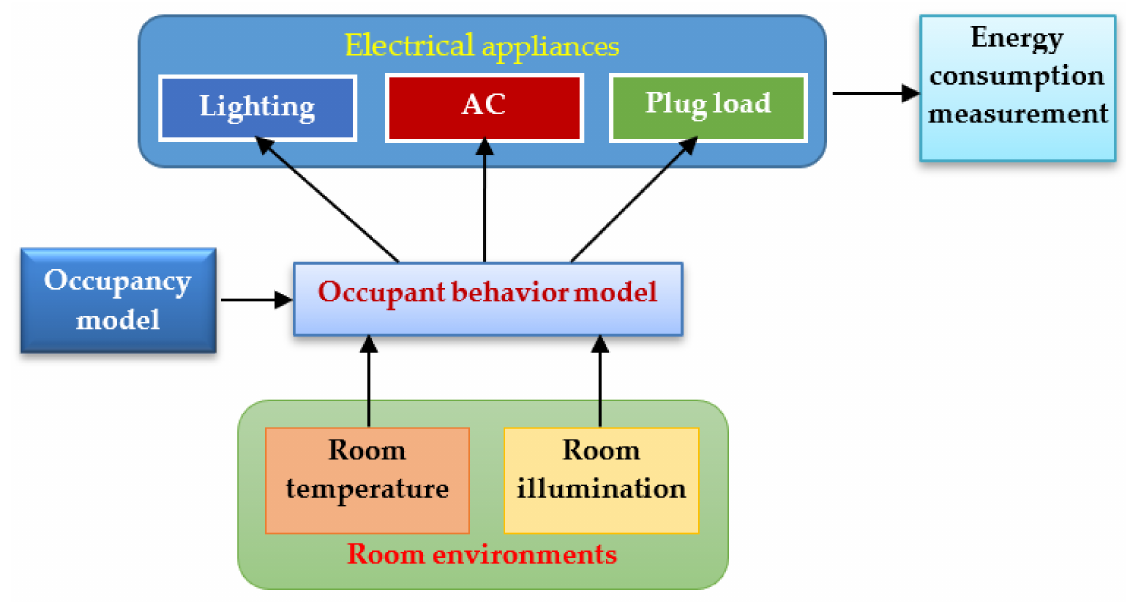
Figure 3. Block diagram of occupancy-based energy consumption model.